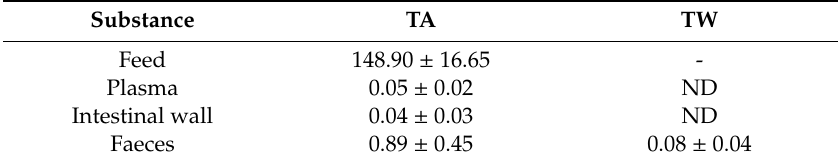
Table 2. Thymol content in plasma ( µ g / L), feed, intestinal wall and faeces ( µ g / g dry matter (DM)). Substance TA TW Feed 148.90 ± 16.65 - Plasma 0.05 ± 0.02 ND Intestinal wall 0.04 ± 0.03 ND Faeces 0.89 ± 0.45 0.08 ± 0.04